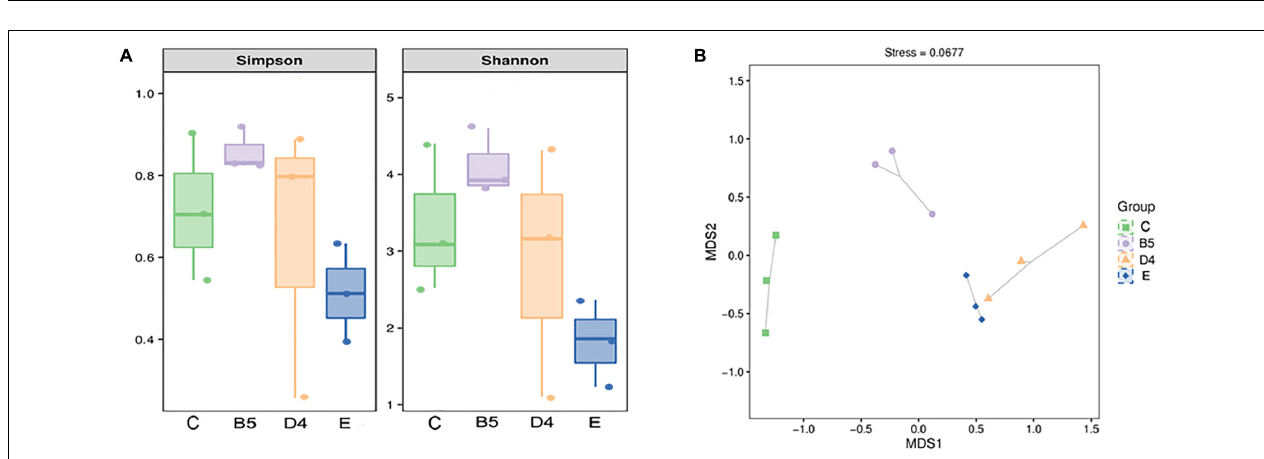
FIGURE 3 | Ensiling characteristics (C) and microbial load by real-time fluorescence quantitative PCR (B) of mulberry leaves silage in trial 3 with experimental design (A) . Different letters in the same index among groups differed ( P < 0.05).